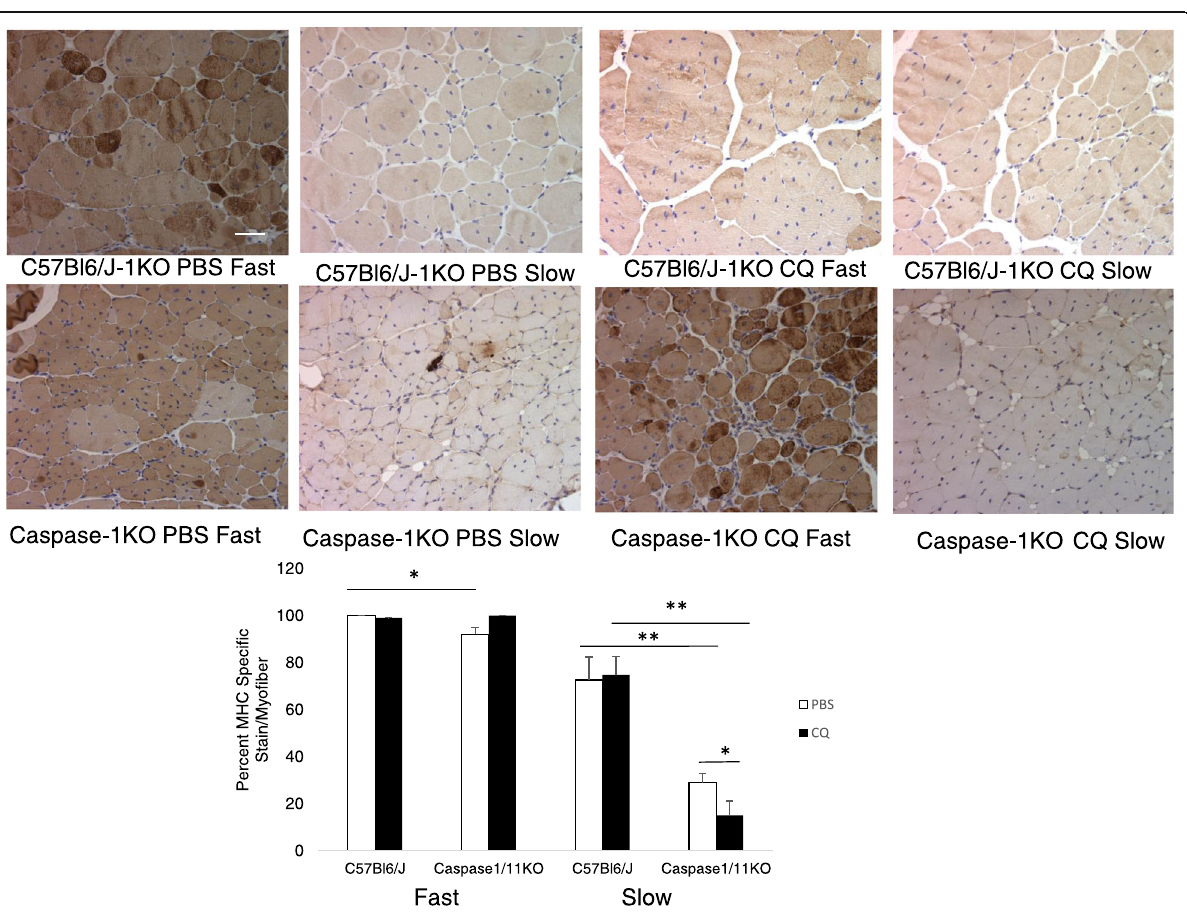
Fig. 6 Loss of caspase1/11 favors regeneration of fast over slow twitch myofibers. Myosin heavy chain (MHC) specific for either fast or slow twitch myofibers in tibialis anterior (TA) muscle from C57Bl/6 J (WT) and caspase-1/11KO mice at 21 days after femoral artery ligation (FAL) treated subsequently with PBS (control) or CQ (50 mg/kg) (upper images); Quantification of fast and slow myofibers expressed as a fraction of total number of regenerating myocytes. Four images were analyzed per limb per animal. * p < 0.05, fast fibers in PBS in WT:KO, slow fibers in PBS:CQ in KO; ** p < 0.001 slow fibers in PBS in WT:KO, slow fibers in CQ in WT:KO. N = 4 mice per strain per treatment group; Scale bar = 10 μ